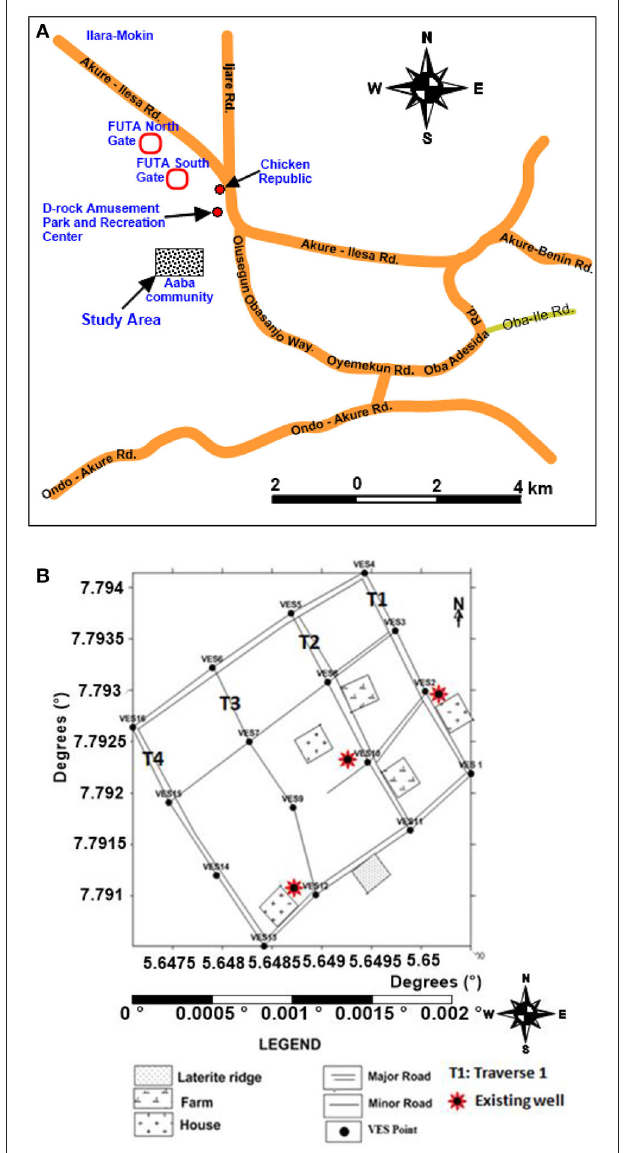
FIGURE 1 | (A) Location of the study area. (B) Base map of the study area.